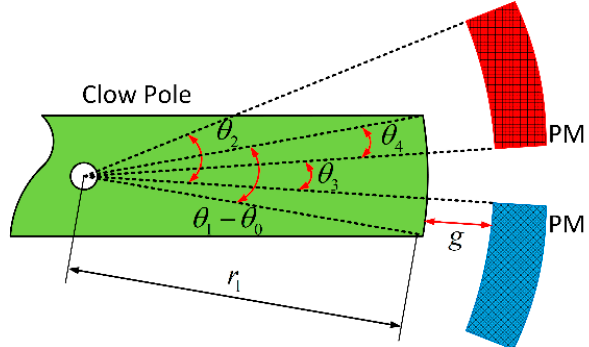
Figure 15. Structure diagram of working air gap.